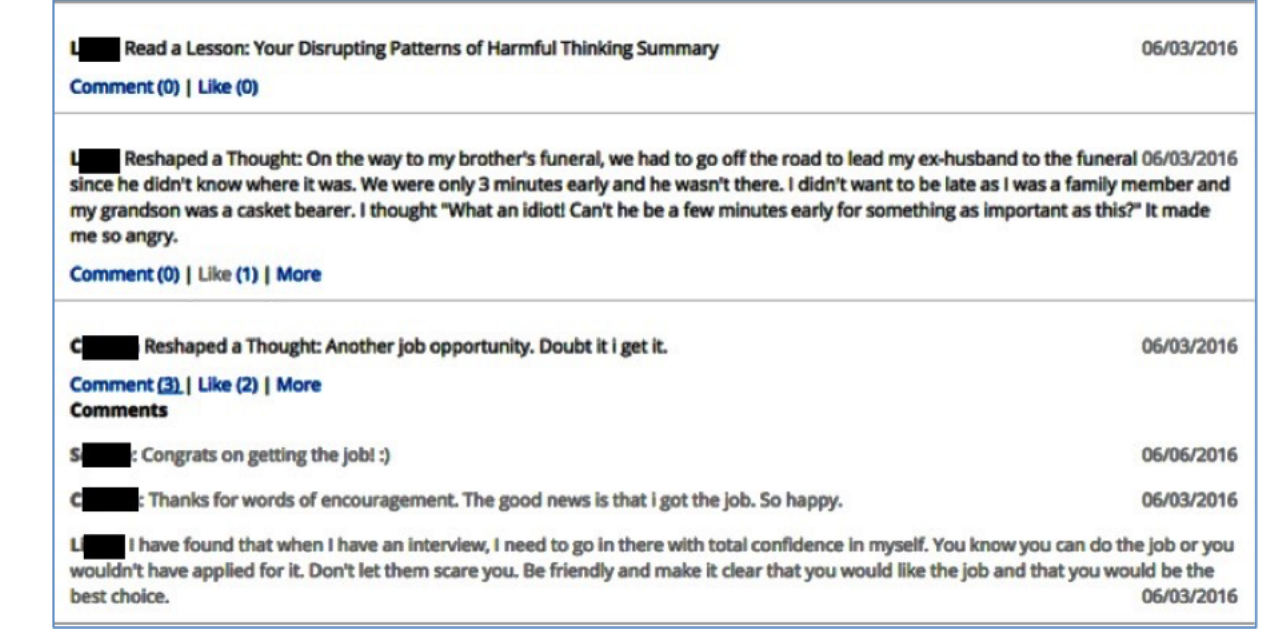
Figure 2. Screenshot of the social peer support feature displaying a portion of social media feed where a negative thought shared publicly had 3 comments and 2